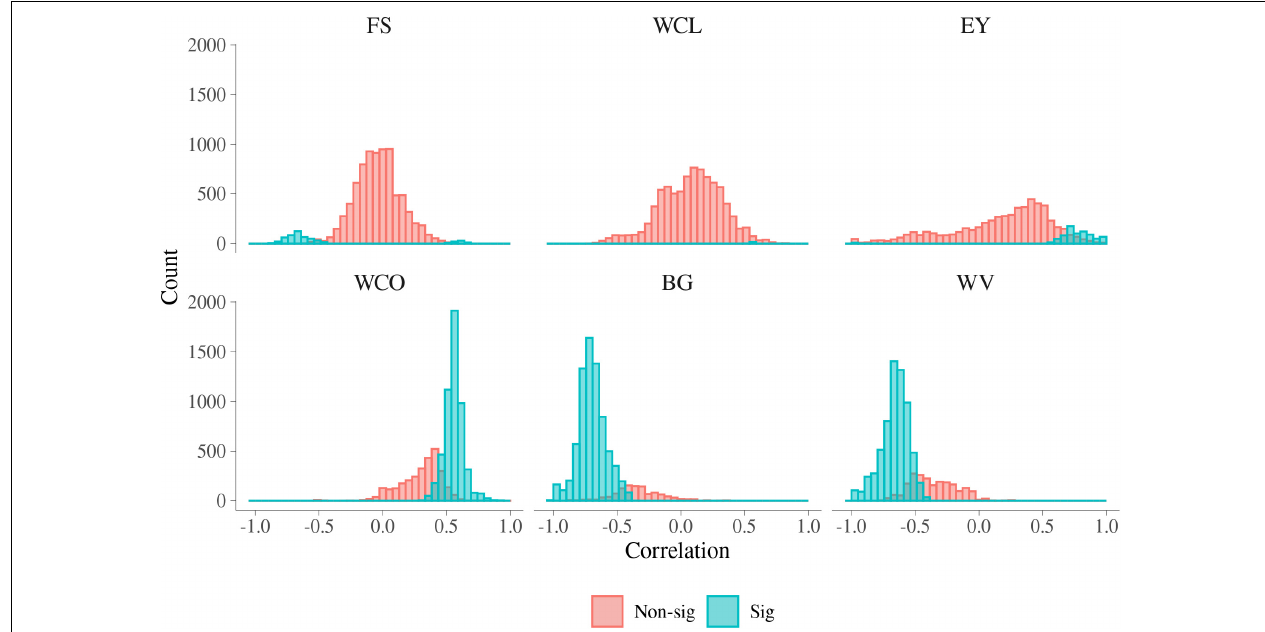
FIGURE 5 | Additive genetic correlations for malting traits with significant metabolomic features. FS, filtering speed; WCL, wort clearness; EY, extract yield; WCO, wort color; BG, beta glucan; WV, wort viscosity.